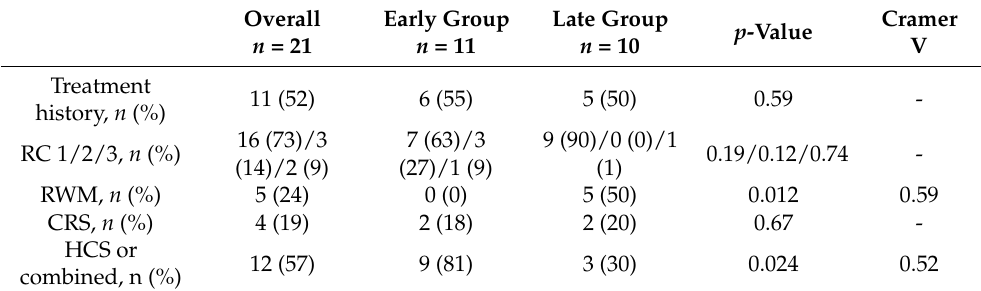
Table 7. Factors associated with early bleeding in the follow-up group: endoscopic